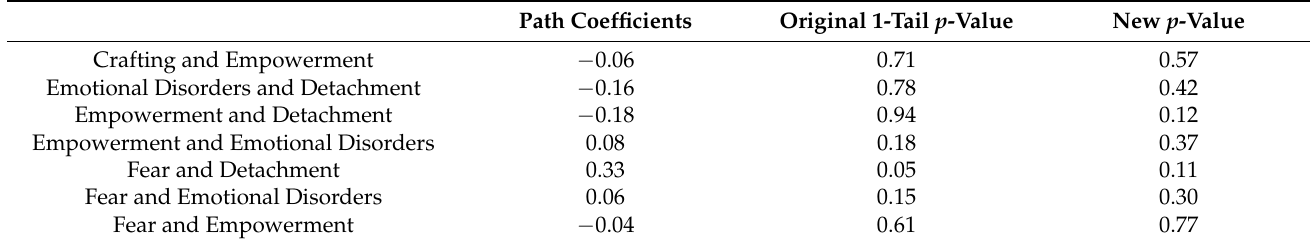
Table 7. PLS-MGA (PLS-Multigroup Analysis